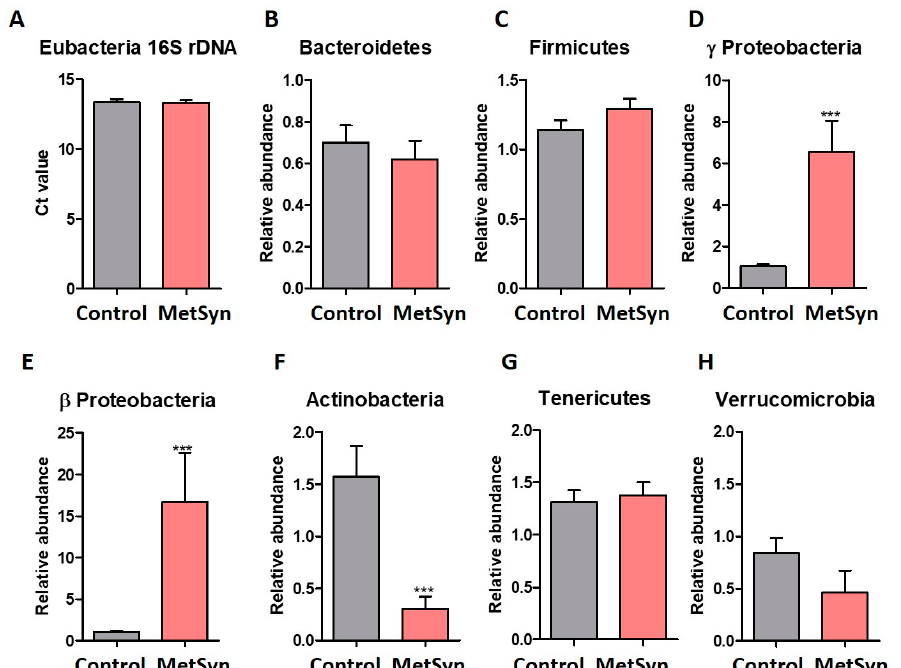
Figure 1. Microbial phyla analysis in MetSyn patients ( n = 30) versus healthy controls ( n = 30). ( A ) Total bacteria represented as Ct values obtained from qRT-PCR targeting the 16S rDNA of all Eubacteria. The abundance of the Bacteroidetes ( B ), Firmicutes ( C ), Gamma Proteobacteria ( D ), Beta Proteobacteria ( E ), Actinobacteria ( F ), Tenericutes ( G ), and Verrucomicrobia ( H ) phyla in fecal samples harvested from healthy individuals and MetSyn patients; *** p < 0.0001, Mann–Whitney test.